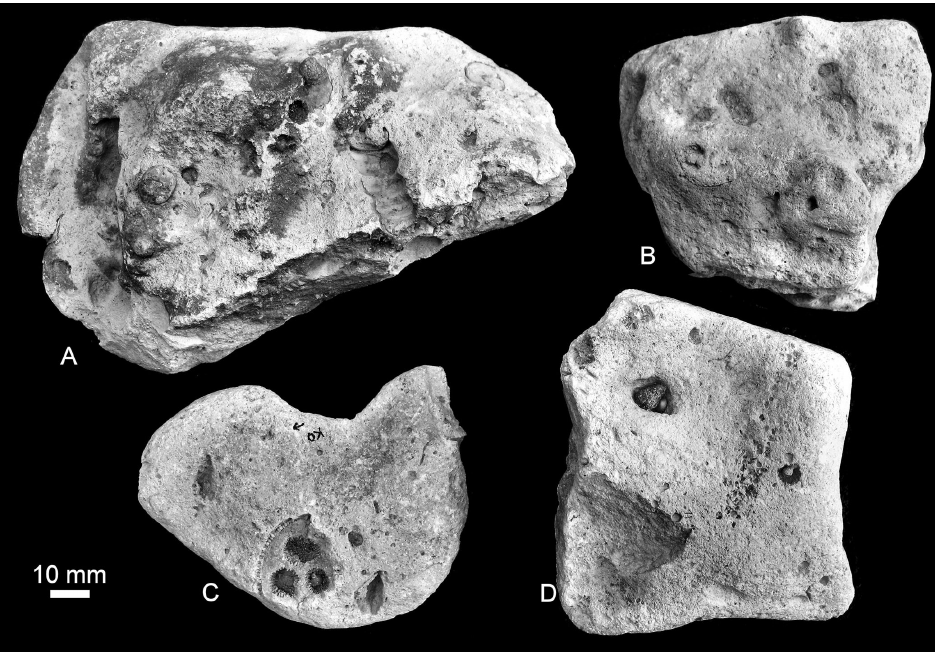
Fig. 3. Boulders of baksteenkalk type 2A: A, RGM 1317630, Wilsum; B, RGM 1317631, Wilsum; C, RGM 1317632, Kloosterhaar; D, RGM 1317633,